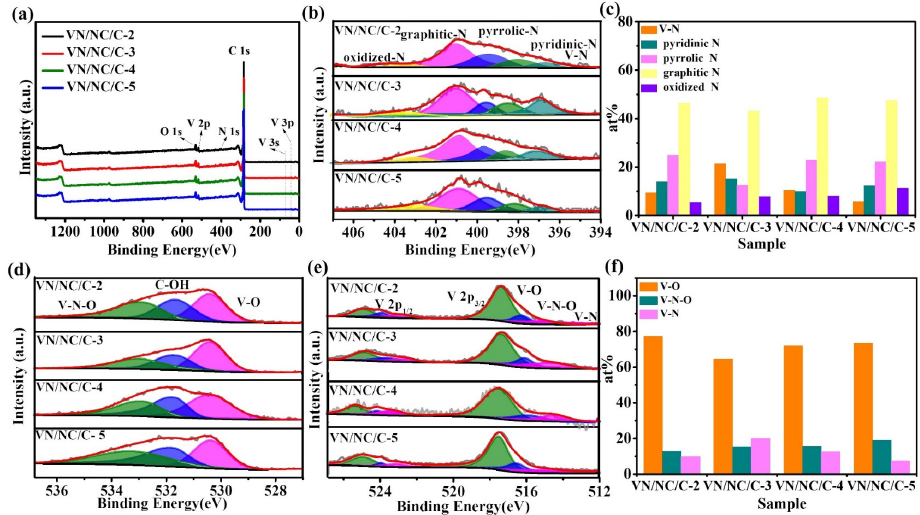
Figure 3. ( a ) XPS survey spectra of the VN/NC/C-x; ( b ) high resolution N1s of VN/NC/C-x; ( c ) different proportions of N 1s in VN/NC/C-x; ( d ) high resolution O 1s of VN/NC/C-x; ( e ) high resolution V 2p of VN/NC/C-x; ( f ) different proportions of V 2p 3/2 in VN/NC/C-x.